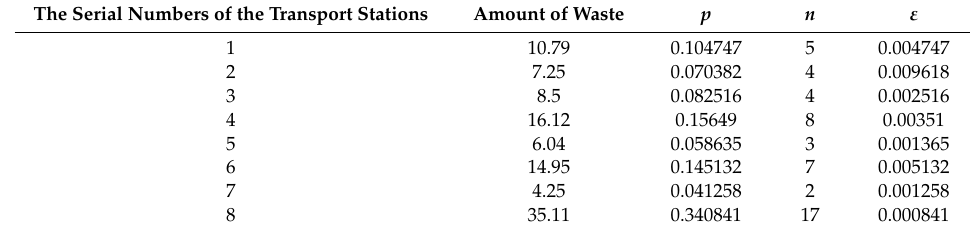
Table 4. Exclusion criteria for areas not suitable for the construction of medical waste disposal stations.